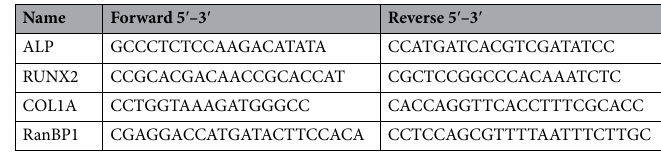
Table 1. Primers used for RTqPCR